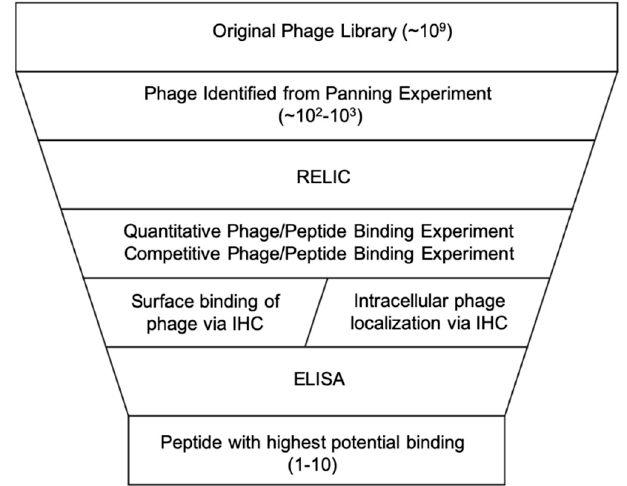
Figure 3. Representation of steps in the phage display process to narrow the phage library down to only peptides with high a ffi nity to the target substrate or cell population. Image modified from [7] and used with permission from